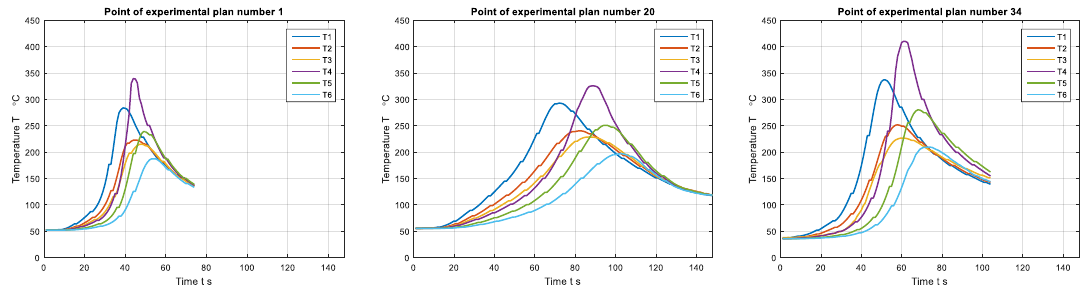
Figure 5. Scheme of measuring temperature positions in the workpiece to be welded [22].